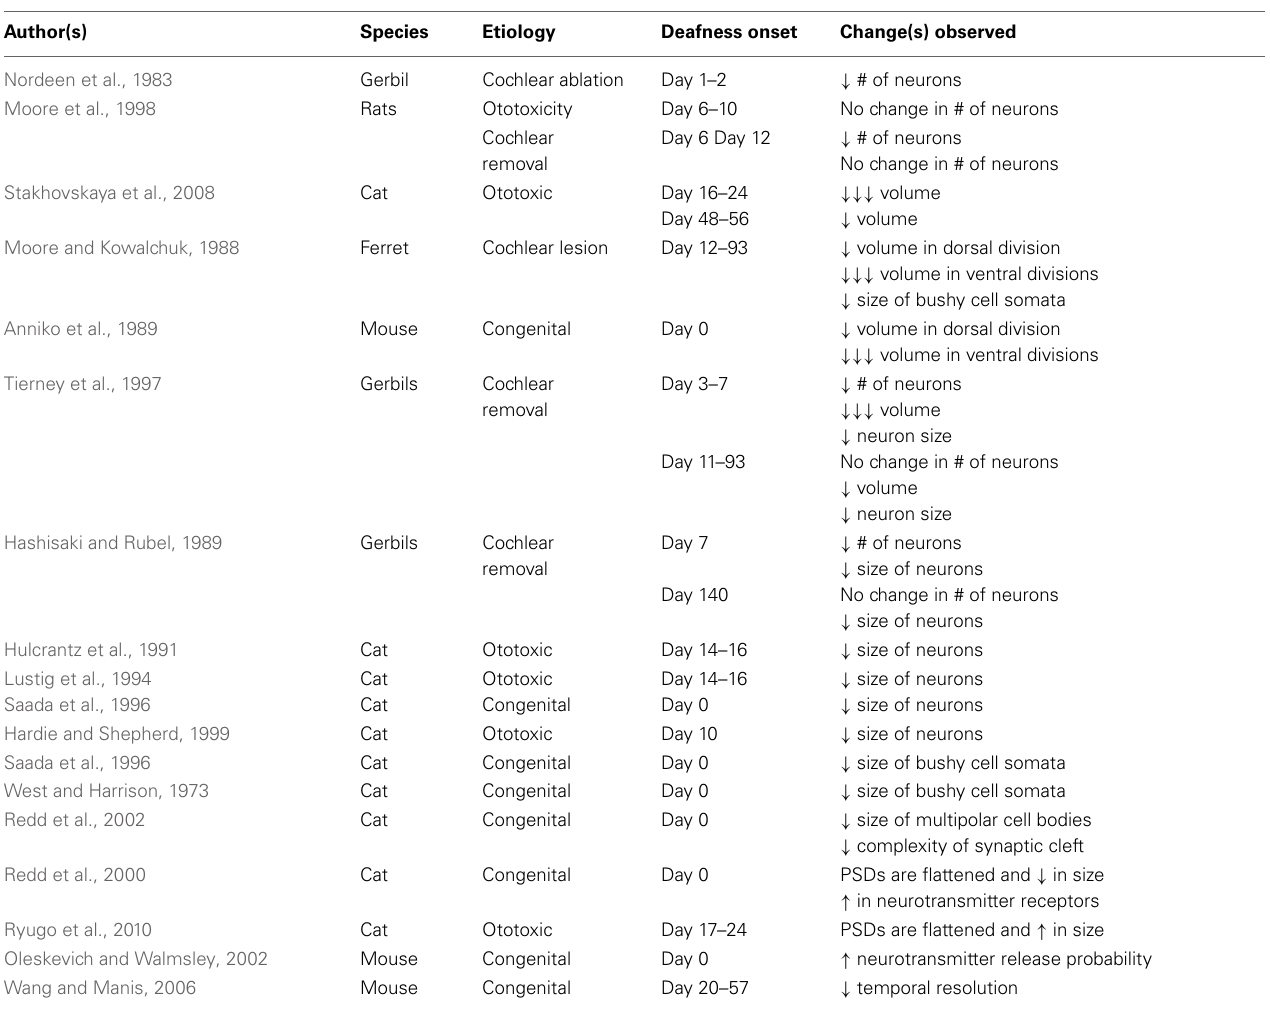
Table 1 | Summary of changes in cochlear